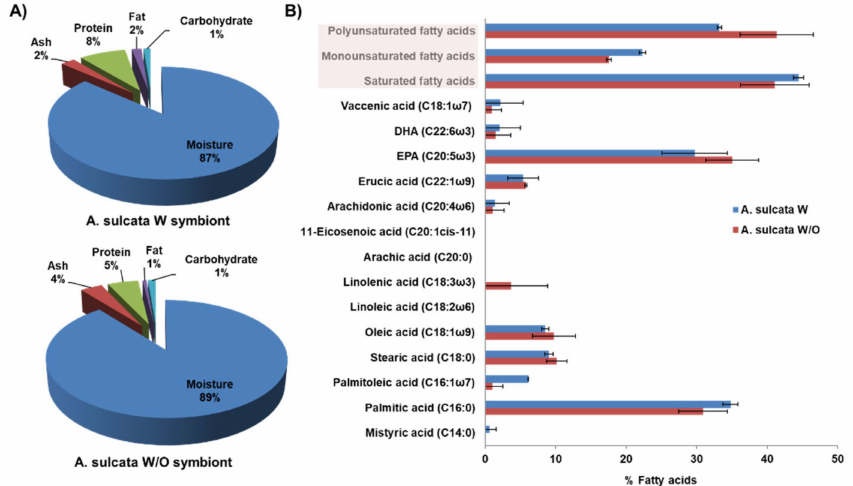
Figure 1. Composition of Anemonia sulcata with (W) and without (W/O) its microalgal symbiont Symbiodinium . ( A ) Graphical representation of the proximate composition. ( B ) Graphical repre- sentation of the fatty acids. The sum of saturated, monounsaturated and polyunsaturated fatty acids is highlighted in the pink box. DHA and EPA are cis-4,7,10,13,16,19-docosahexaenoic acid and 5,8,11,14,17-eicosapentaenoic acid, respectively. Data are represented as the mean ± standard deviation of duplicate